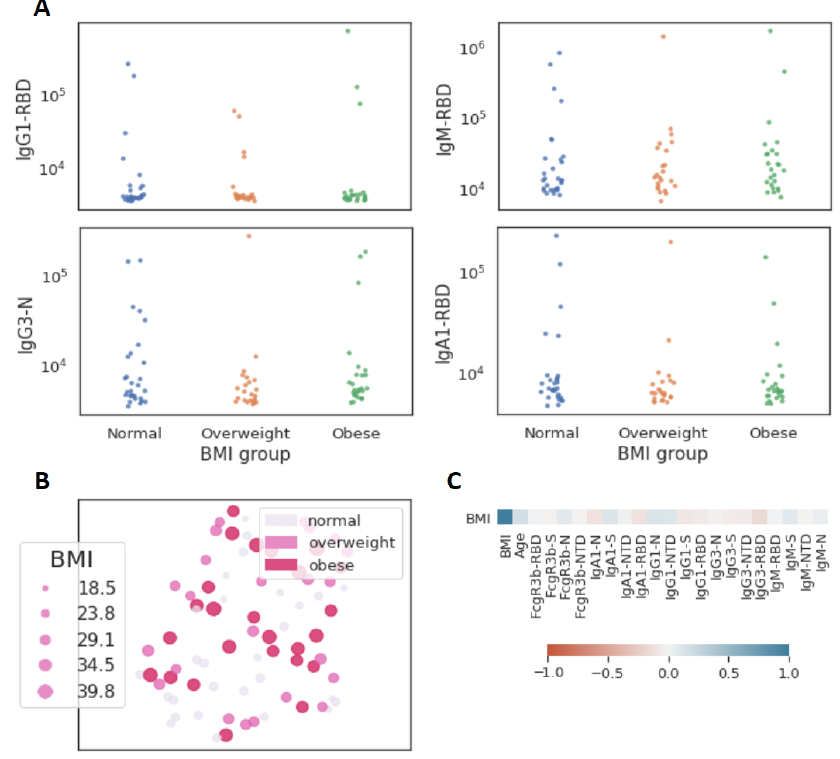
Figure 5. Limited influence of BMI on SARS-CoV-2 antibody profiles ( n = 77). ( A ) The dot plots show similar mean fluorescent intensity levels of IgG1, IgM, IgG3, and IgA levels across individuals classified as normal weight ( n = 29), overweight ( n = 23), and obese ( n = 25). ( B ) The uniform manifold approximation and projection (UMAP) shows the relationship between antibody profiles and BMI (dot size, color intensity), highlighting the limited influence of BMI on shaping SARS-CoV-2 antibody responses. ( C ) Correlation plot of shows limited correlation between BMI and 20 immunological features.